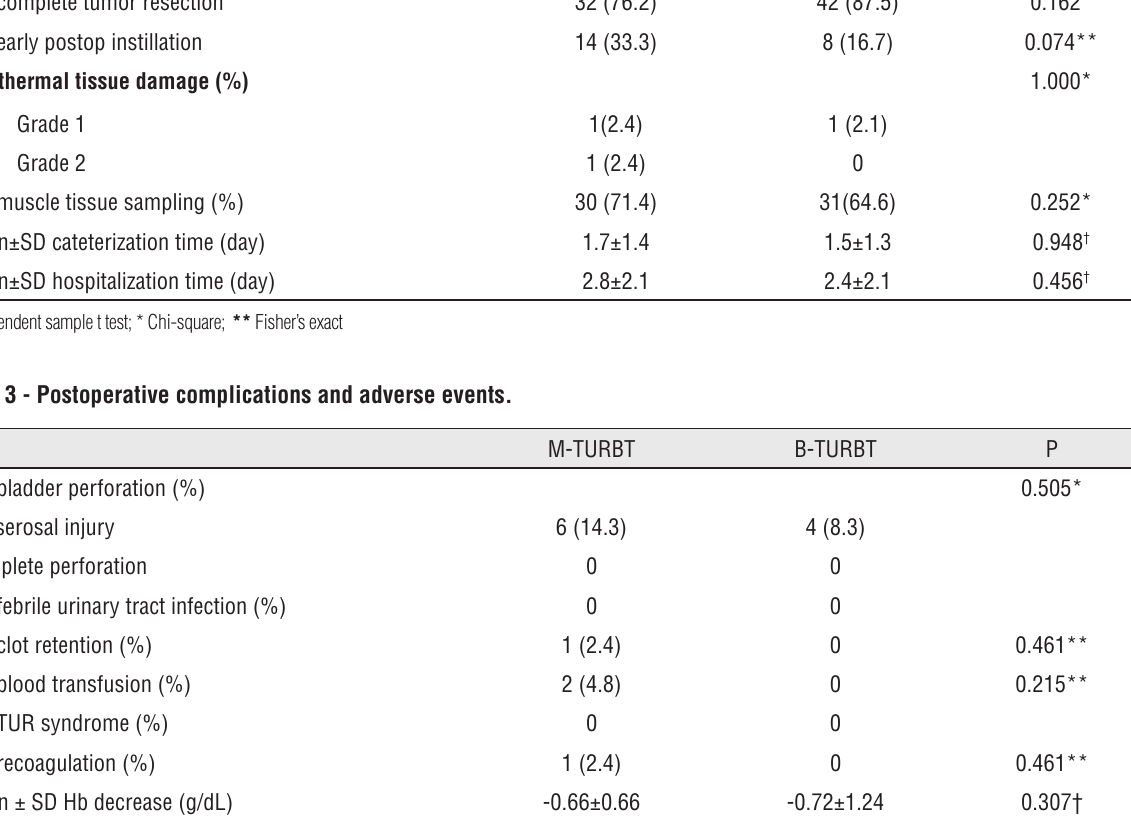
Table 2 - Intraoperative and postoperative outcomes. Mean±SD operation time (min.)